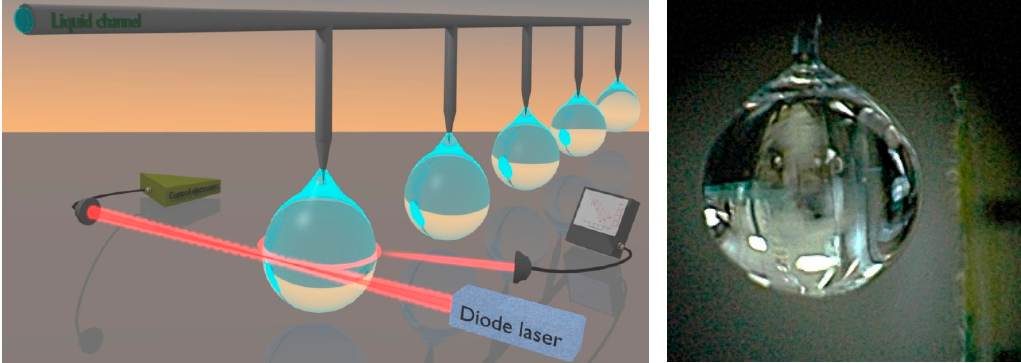
Figure 2. Left : 3D rendering of the optical scheme for excitation of a droplet cavity by a free-space laser beam (Reproduced with permission from [27]). Right : photograph of a liquid-paraffin droplet ( ∼ 1.5 mm diam) hanging from the tip of a silica fiber with acrylic coating (250- μ m outer diam). The whispering-gallery modes may be excited by focusing a free-space beam at the droplet rim, tangential to the surface, without using any special coupling device. In this configuration, the focus optimal position is slightly inside the surface edge and the cavity is undercoupled, typically with 5%– 10% of the incident power being effectively injected into low-order WGMs [27]. The overall coupling efficiency also depends on the microresonator Q (and thus on the excitation wavelength) as the laser- emission spectral overlap with the cavity mode decreases with decreasing the mode linewidth [25]. A careful alignment of the droplet into the laser beam requires an xyz micrometric translation stage while microscope objectives are adopted to focus the laser radiation and collect the directly transmitted and scattered beams by the droplet on separate photodetectors. This alignment is easily reproducible and gives always similar mode patterns, even for different sizes. Thanks to the natural liquid damping, acoustic noise and air flows in the laboratory do not seriously perturb the cavity. Basically, the main physical mechanisms responsible for optical coupling from free-space are believed to be surface scattering [28,29] and chaos-assisted tunneling [30], whereas evanescent-wave matching is not relevant due to the small droplet curvature (for radii >50 μ m) [31,32]. As remarked in ref. [33], van de Hulst’s localization principle fails in the case of a droplet with surface irregularities. Thus, weak distortions caused by thermal capillary waves induce angular-momentum coupling of partially-scattered light waves to the resonator WGMs achieving the highest excitation efficiency for a beam impact parameter slightly smaller than the drop radius [33,34], in agreement with experimental findings. If a current scan is sent to the laser, several WGM spectra can be observed in a few-ms time. Figure 3 shows 5 narrow resonances detected for a liquid paraffin droplet (300 μ m radius), over a cavity free-spectral-range, using a 640-nm diode laser as a light source. Here, peaks appear in the scattering while corresponding dips appear in the transmission. The scattered light is collected both in a quasi-counterpropagating direction (passing backwards through the focusing objective) and at a 90-degree angle with respect to the incident beam (side-scattering), observing different lineshapes around the resonances. These spectra are highly repeatable and the alignment of the droplet is not critical to the quality factor as opposed to tapered-fiber or prism coupling schemes [34]. The Q-factors of the droplet cavities have been characterized with cavity ring-down spectroscopy [27,35], as shown in the next section. At a wavelength of 640 nm, the longest measured lifetime was (6.35 ± 0.05) ns, corresponding to a Q-factor of (1.87 ± 0.01) × 10 7 .